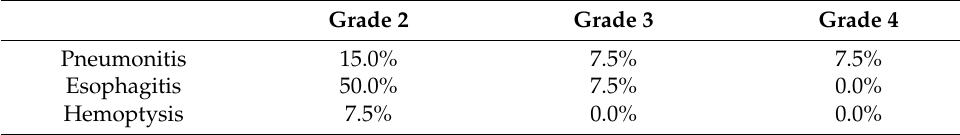
Table 4. Toxicities experienced by all patients receiving radiochemotherapy.